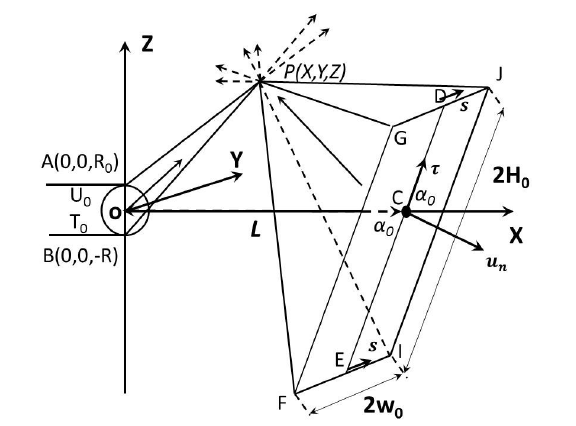
Figure 11. Illustration of the problem of a round jet impinging on a diffuse reflective plate.